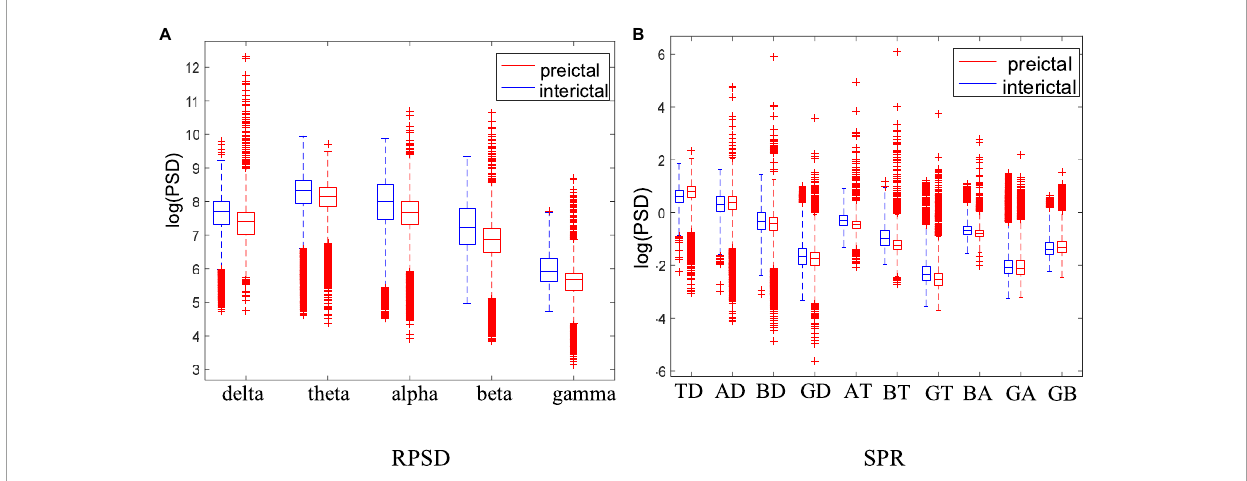
FIGURE7 Comparison of the RPSD and DRPSD in Dog4. (A) Is the RPSD and (B) is the SPR. Note that the abscissa label of panel (B) represents the difference values obtained by subtracting two different RPSDs. Specifically, TD, theta minus delta; AD, alpha minus delta; BD, beta minus delta; GD, gamma